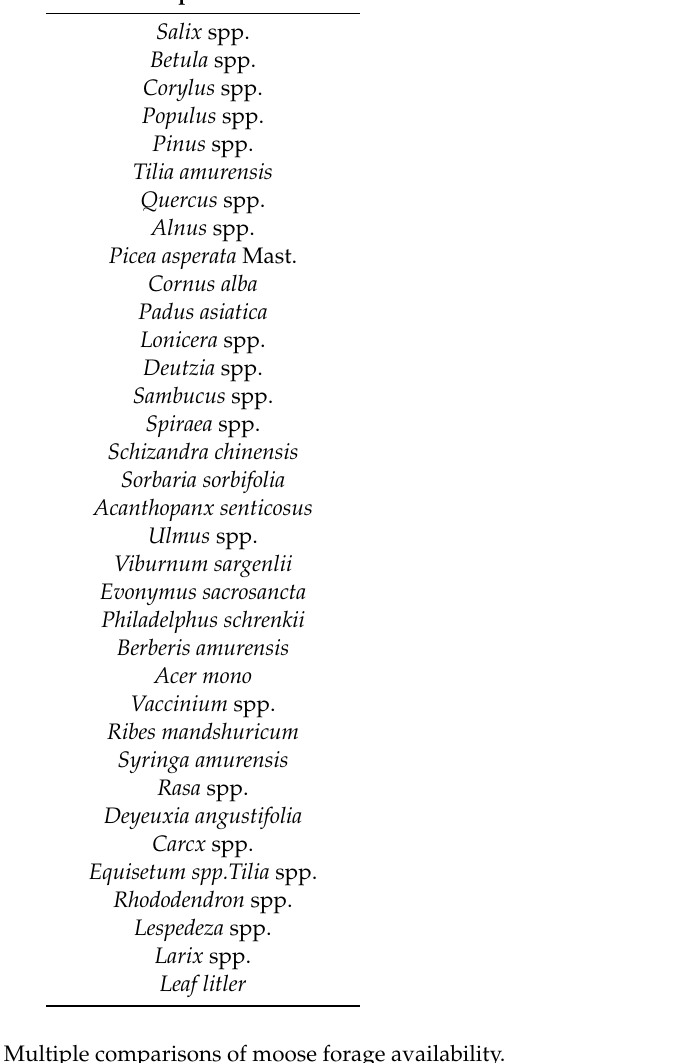
Table A2. Multiple comparisons of moose forage